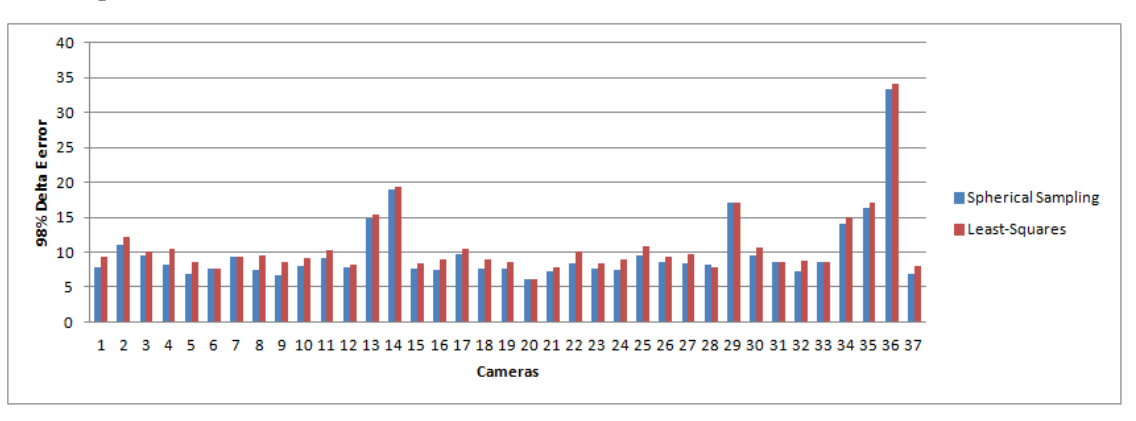
Figure 5. Ninety eighth percentiles per camera for both spherical sampling (blue) and least-squares (red).